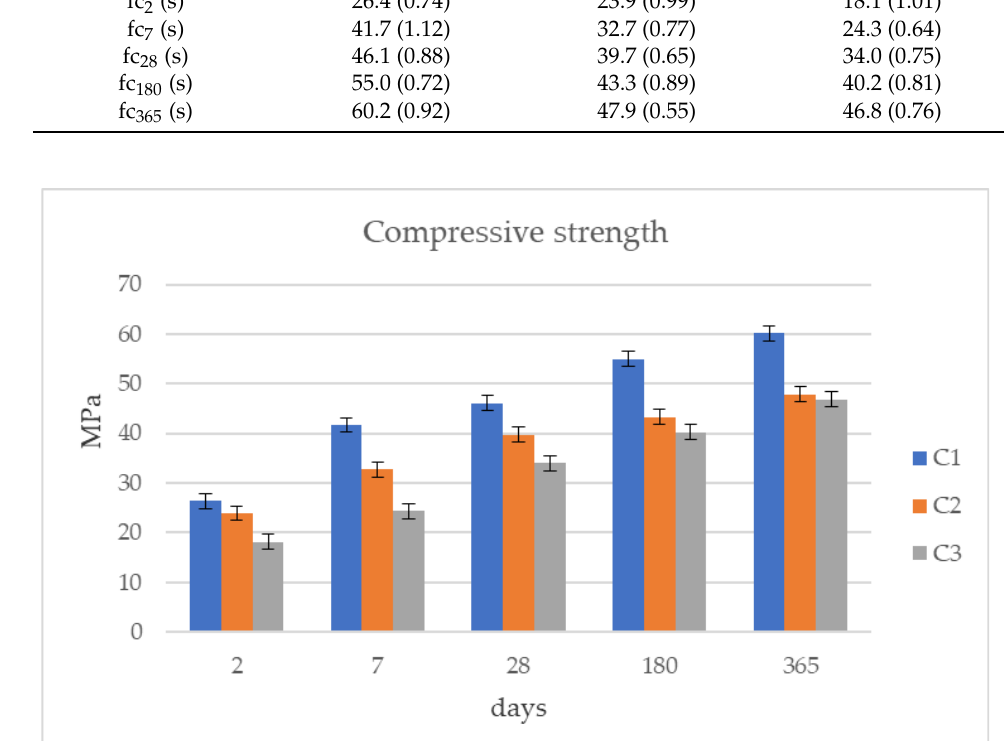
Figure 5. Compressive strength (MPa) of C25/30 strength class mixtures.